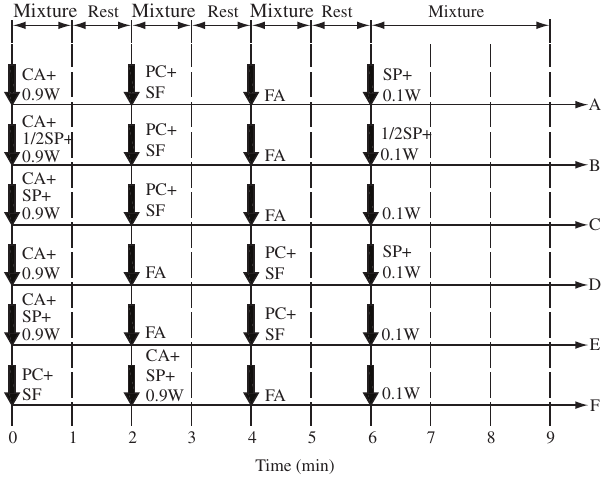
Figure 3. Mixing procedure used in high performance concretes production, where: W = water, FA = fine aggregate, CA = coarse aggregate, PC = portland cement, SF = silica fume and SP = superplasticizer.